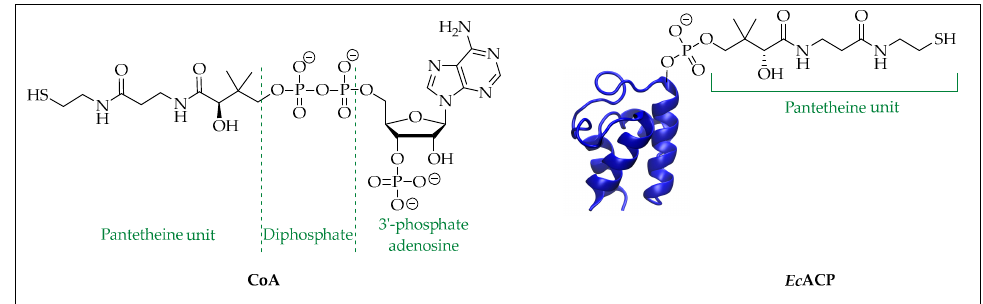
Figure 1. Structures of CoA and Ec ACP (PDB ID 6N3P) [10].